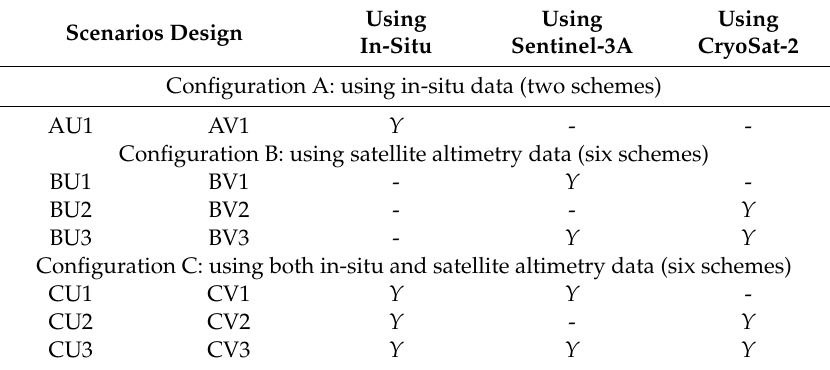
Table 3. Summary of hydrodynamic model